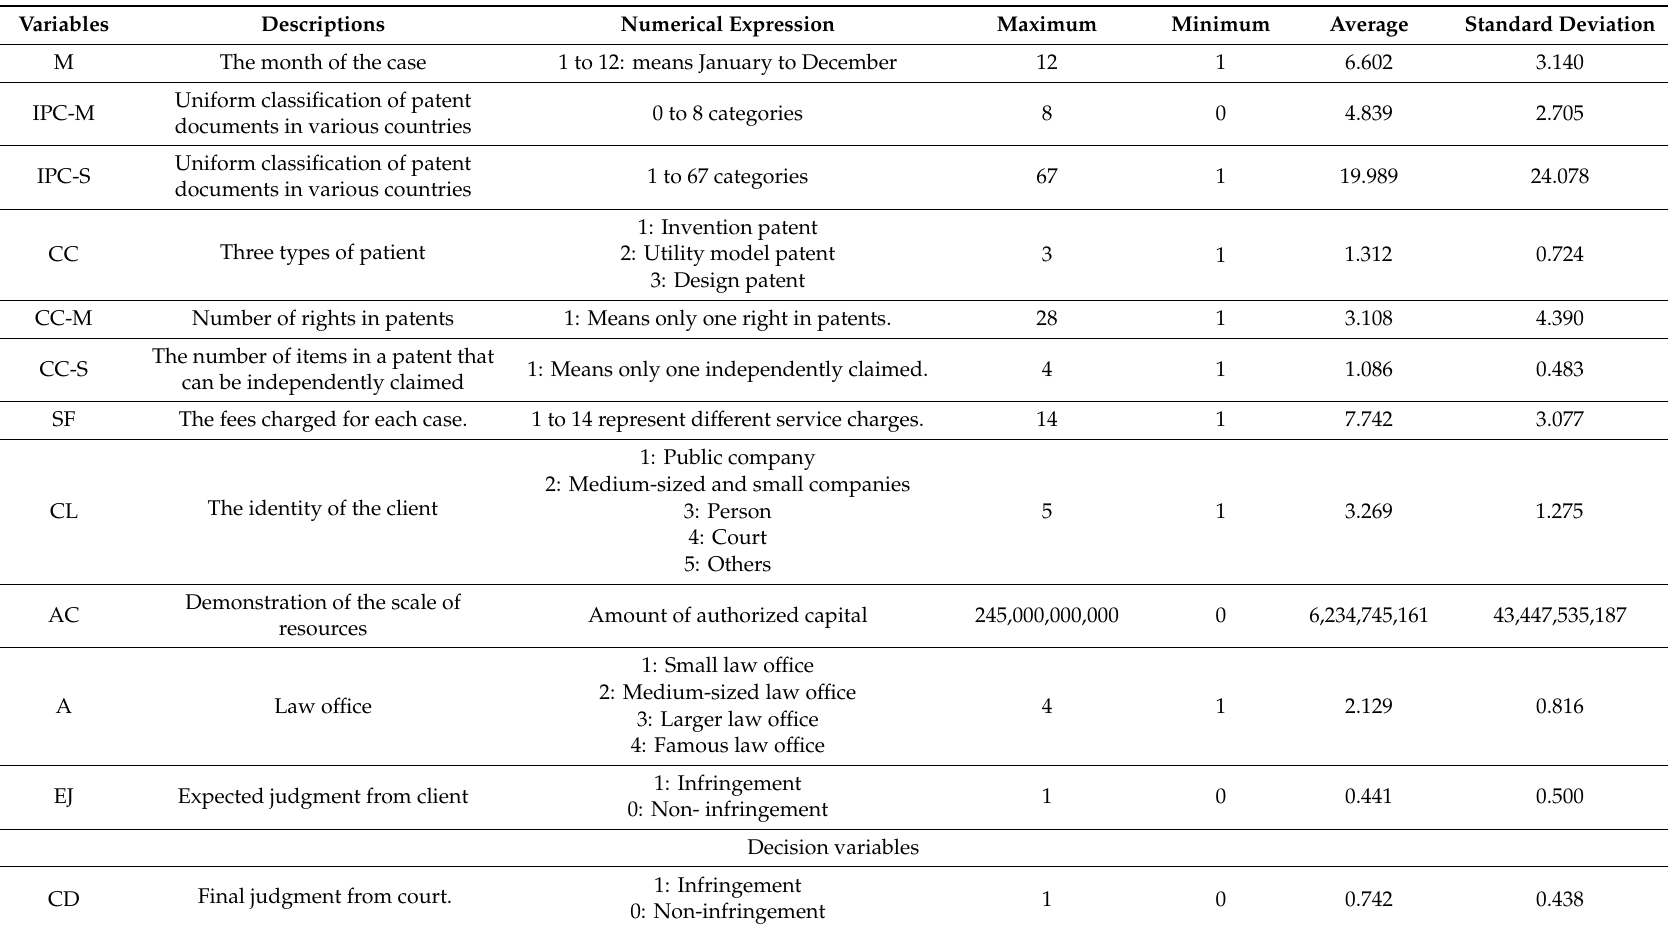
Table 2. Summary of statistics and variable information of patent infringement